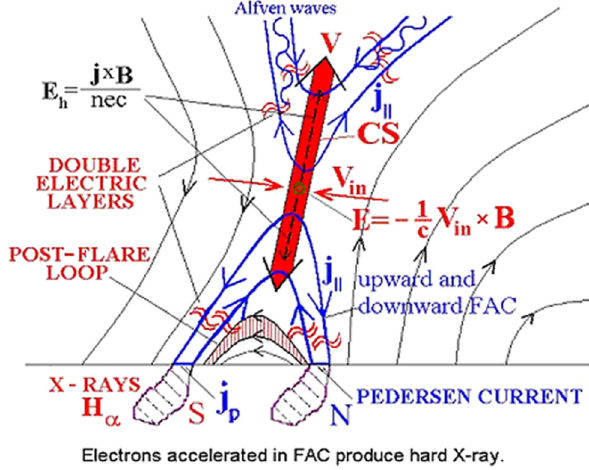
Figure 1: Electrodynamic model of a solar fl are by Podgorny based on Interkosmos - Bulgaria - 1300 satellite